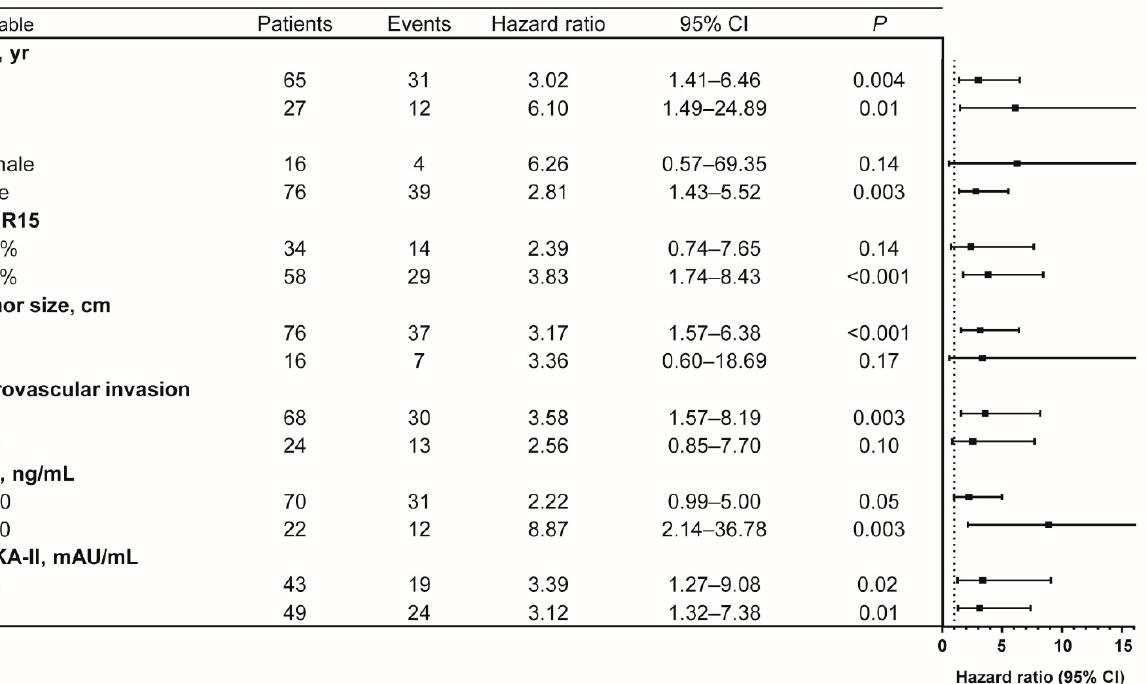
Figure 3. Forest plot of recurrence-free survival by baseline serum SORD levels in patient subgroups. Hazard ratio for patients with elevated serum SORD levels ( ≥ 15 ng/mL) compared with patients with low serum SORD levels (<15 ng/mL) as a reference.